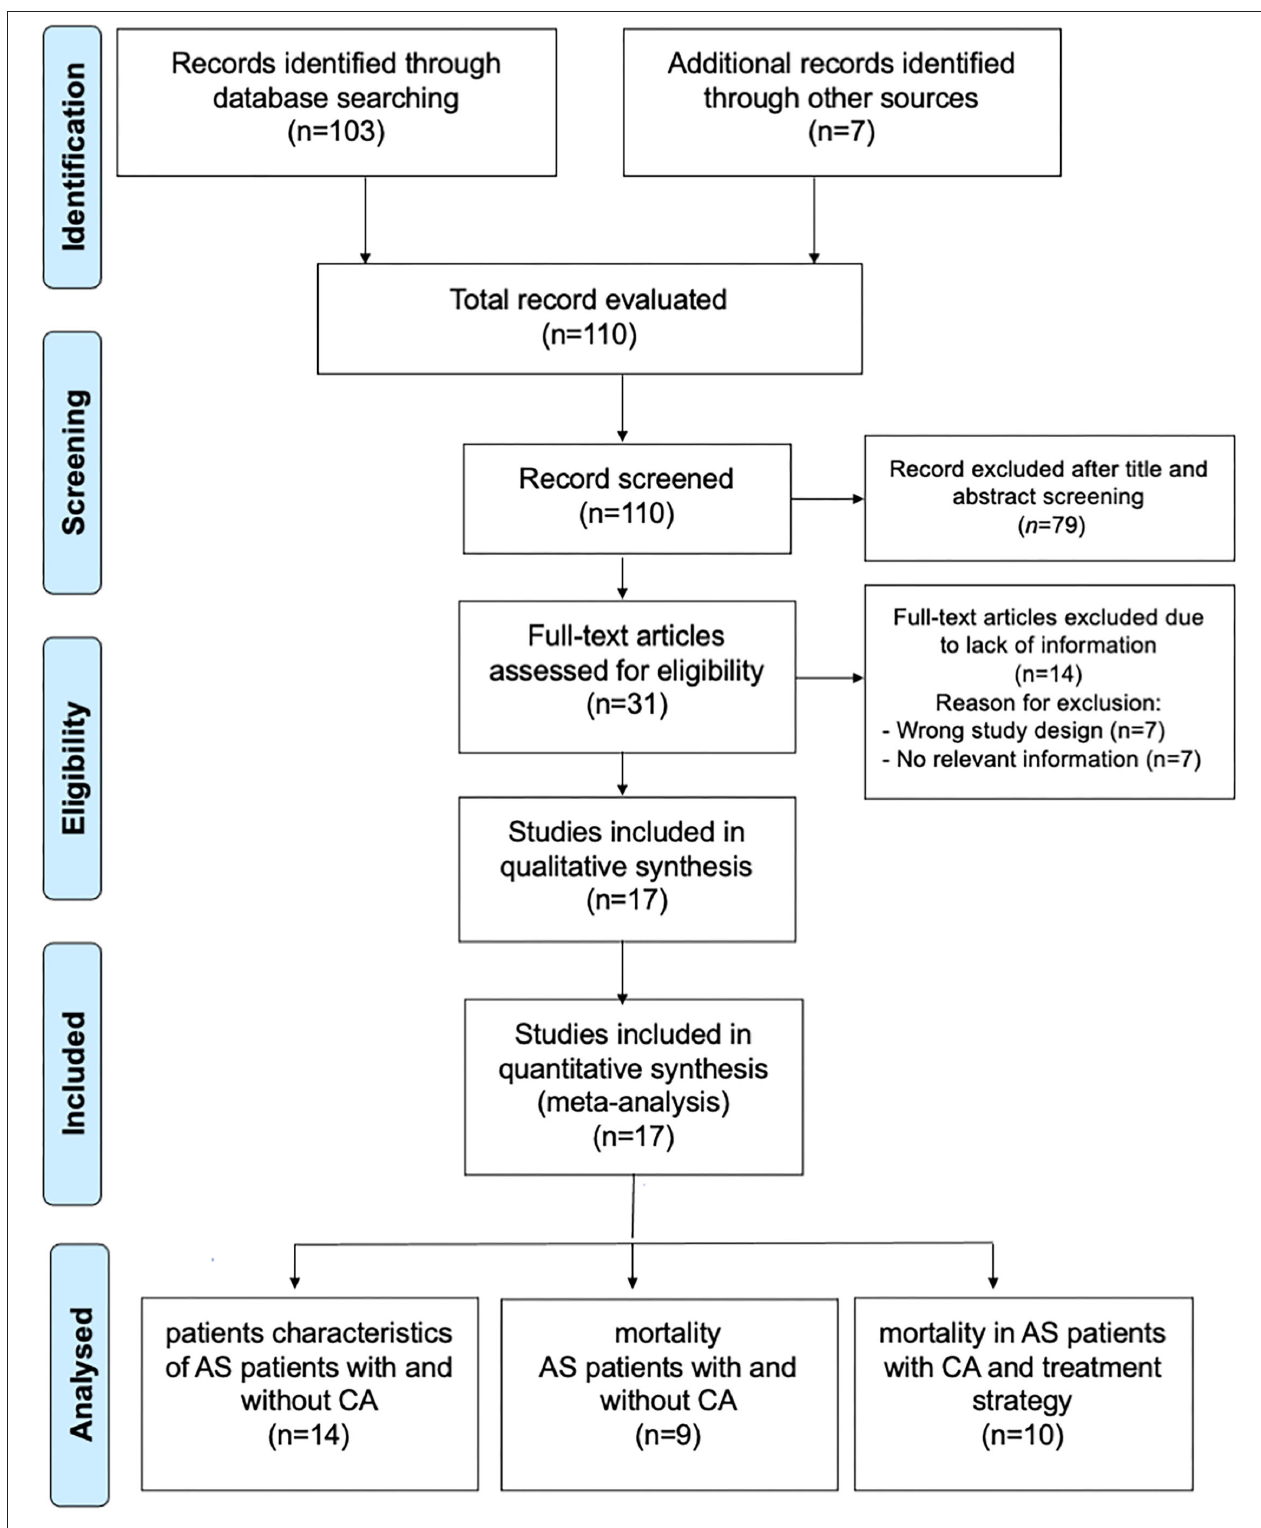
FIGURE 1 | Prisma Flow Chart. The flow chart represents the number of studies evaluated according to PRISMA guidelines.